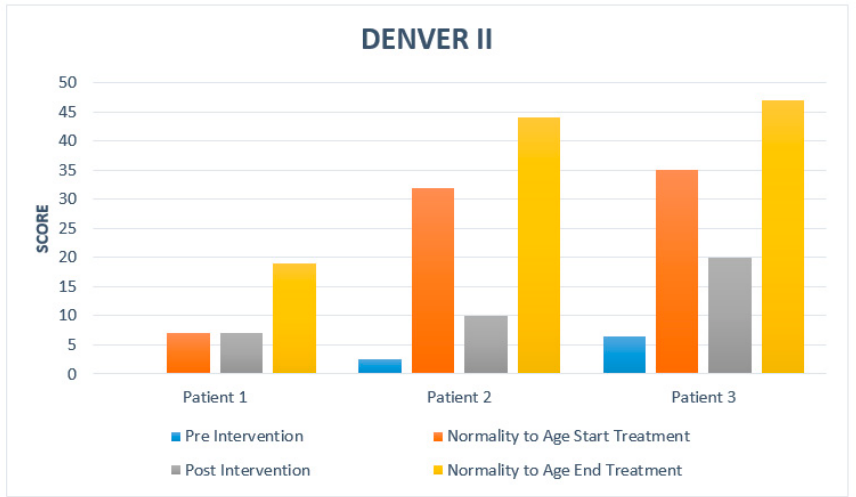
Figure 3. Patient score and comparison with normality based on DENVER Test II.